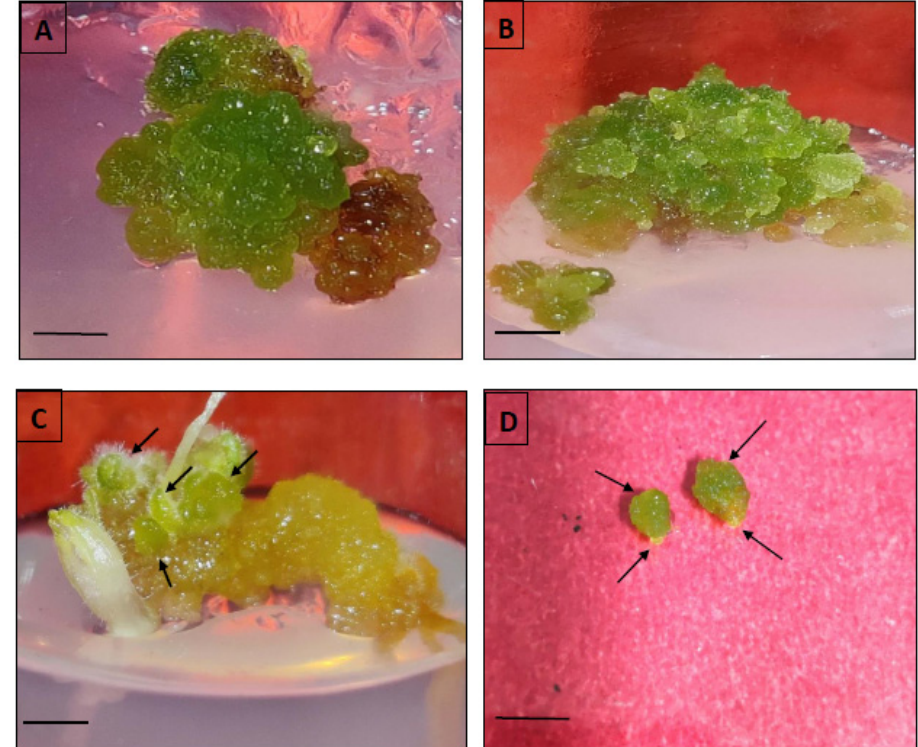
Figure 3. Callus induction and indirect somatic embryogenesis from hypocotyl callus in D. purpurea . ( A , B ) Callus induction and proliferation (bars (A) = 0.3 cm, (B) = 0.5 cm), ( C ) Somatic embryos formation with different developmental stages (bar = 0.5 cm), ( D ) Isolated bipolar stages of early and late globular embryos with shoot and root ends (arrowheads) (bar = 0.3 cm).